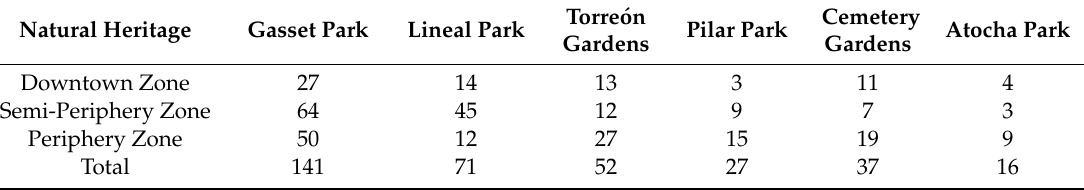
Table A4. Results of answers related to natural heritage.